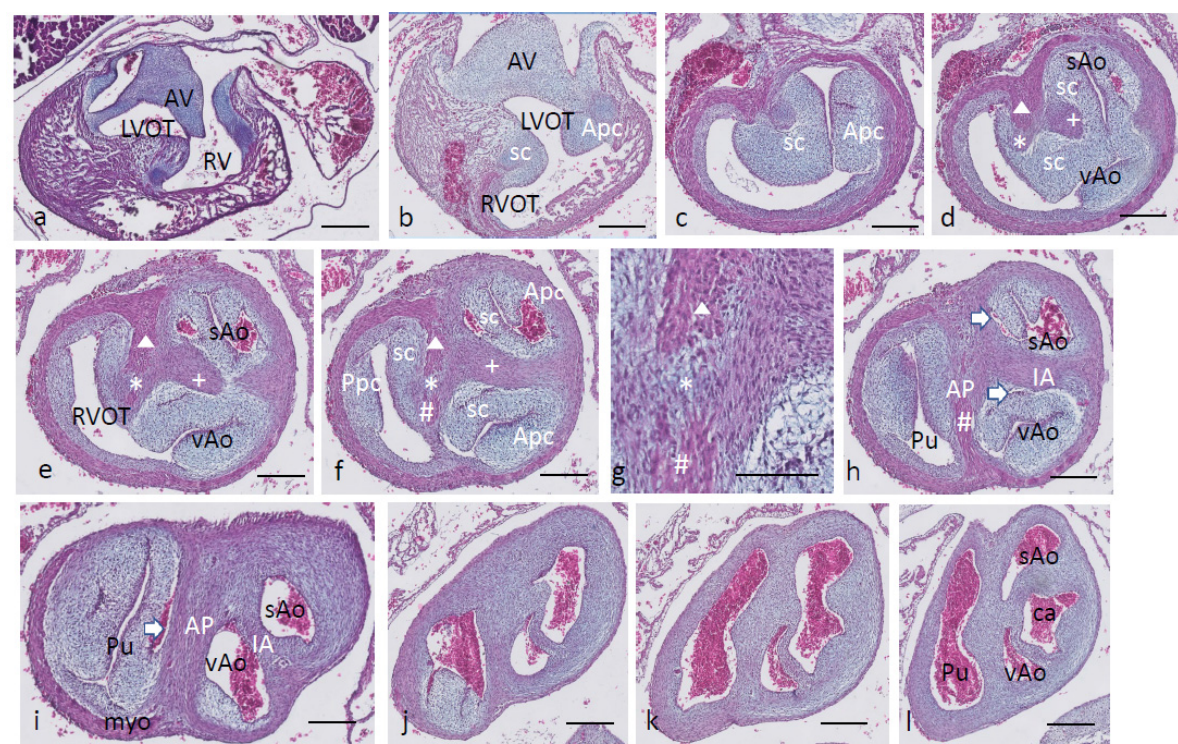
Figure 3. Ferguson stage 20, Figure ( a – l ) from AV canal to OFT. Figure ( a ), both in the septal and aortic parietal cushions, cartilage is forming (dark blue) which is less evident more distally (Figure ( b )). Figure ( c ), the septal cushion containing condensed mesenchyme has a central position. Figure ( d , e ), the septal cushion becomes subdivided by both prongs of condensed mesenchyme, belonging to the IA septum (+) and AP septum (*), where the remnant of the folding septum is indicated ( Δ ). Figure ( f ), the condensed mesenchyme of the IA septum bridges the gap to the aortic parietal cushion whereby the systemic and visceral aortas become separated at this level. The AP septum now contains 3 elements. Enlargement in Figure ( g ), condensed mesenchyme (*), flanked by the myocardium of the folding septum ( Δ ) and the ventral myocardium (#). Figure ( h ), both IA and AP septa are fully developed at this level. The arrows indicate the sinus of Valsalva in the systemic and visceral aortas. Figure ( i ), the arrow indicates a sinus of Valsalva in the pulmonary trunk. Figure ( j – l ) illustrate the branching of the arterial tree, including the pulmonary arteries, and the carotid arteries from the systemic aorta. The visceral aorta does not branch further. Key to the symbols # ventral myocardium, part of AP septum; * (presumably) left-sided neural crest cells, part of AP septum; + (presumably) right-sided neural crest, part of IA septum; Δ dorsal myocardium, part of AP septum. Magnification Figure ( a – f , h – l ), 500 µm; ( g ), 100 µm.